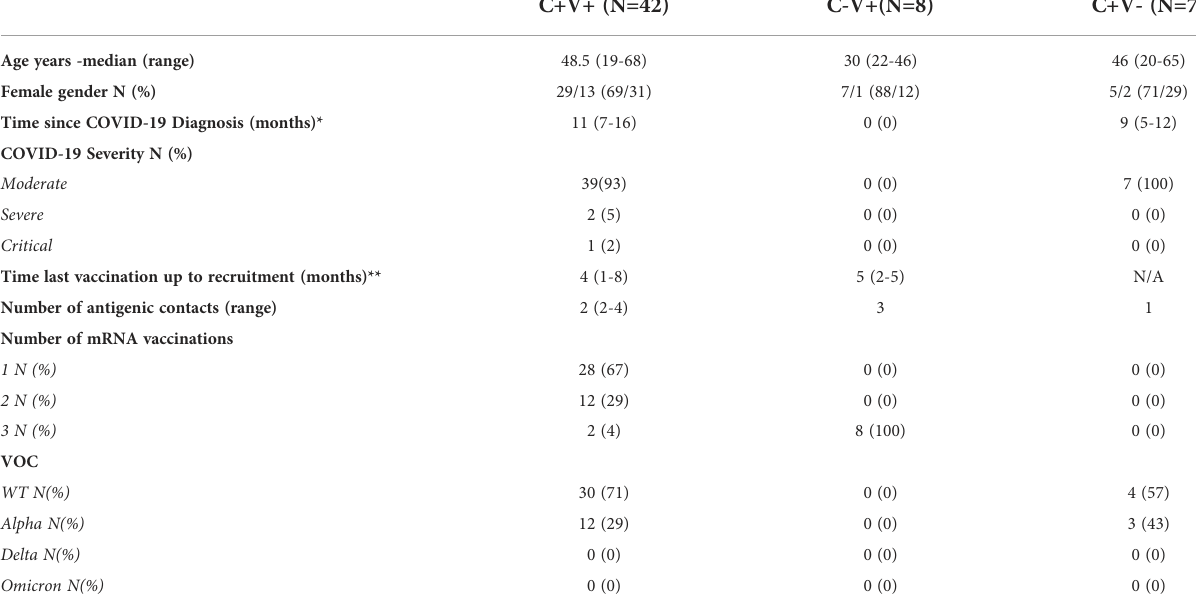
TABLE 1 Demographic and clinical characteristics of the study